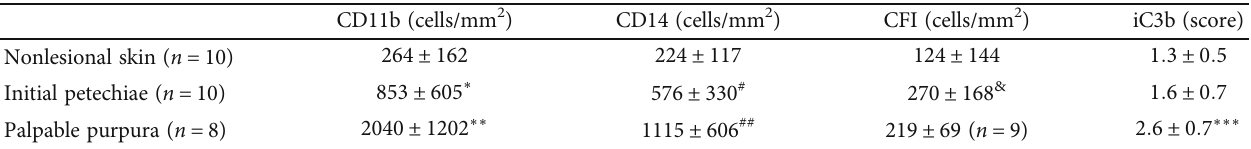
Table 1: The number of CD11b + , CD14 + , or complement factor I (CFI) + cells and the staining score of iC3b in skin biopsies from patients with immunocomplex-mediated cutaneous small vessel vasculitis.